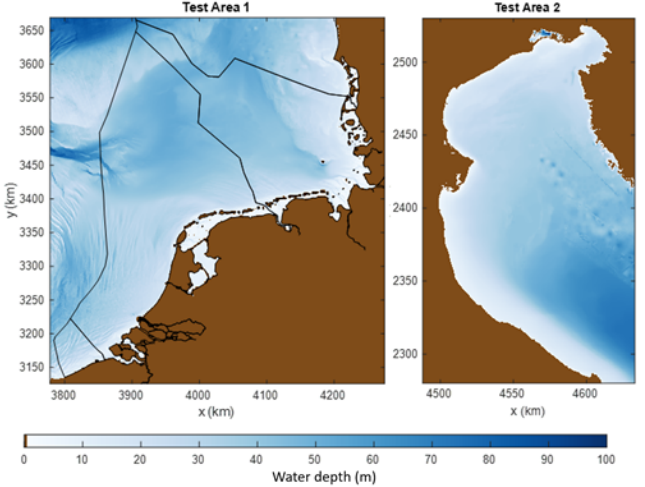
Figure 1. The selected test areas and their bathymetries. Test area 1 (the Dutch, Belgian and German Exclusive Economic Zones in the Southern North Sea) and test area 2 (The Gulf of Venice). Test area 1 partly involves the Danish, French and English Exclusive